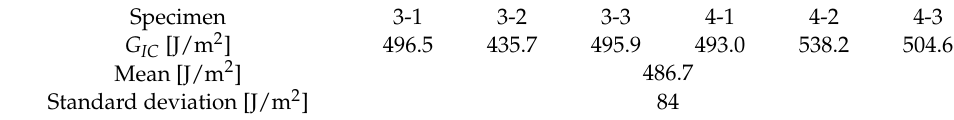
Table 1. Experimentally determined values of crititcal strain energy release rate G IC .